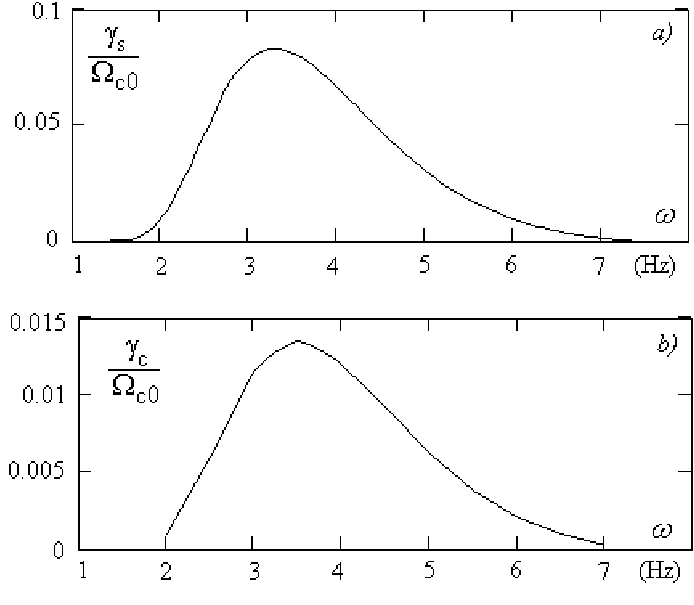
Fig. 3. The growth rates versus ω for EMIC waves in the hydrogen plasmas confined in the straight magnetic field (a) , and in the magnetosphere with circular magnetic field lines (b) , under the same macroscopic bulk parameters. The large difference between γ s and γ c is connected